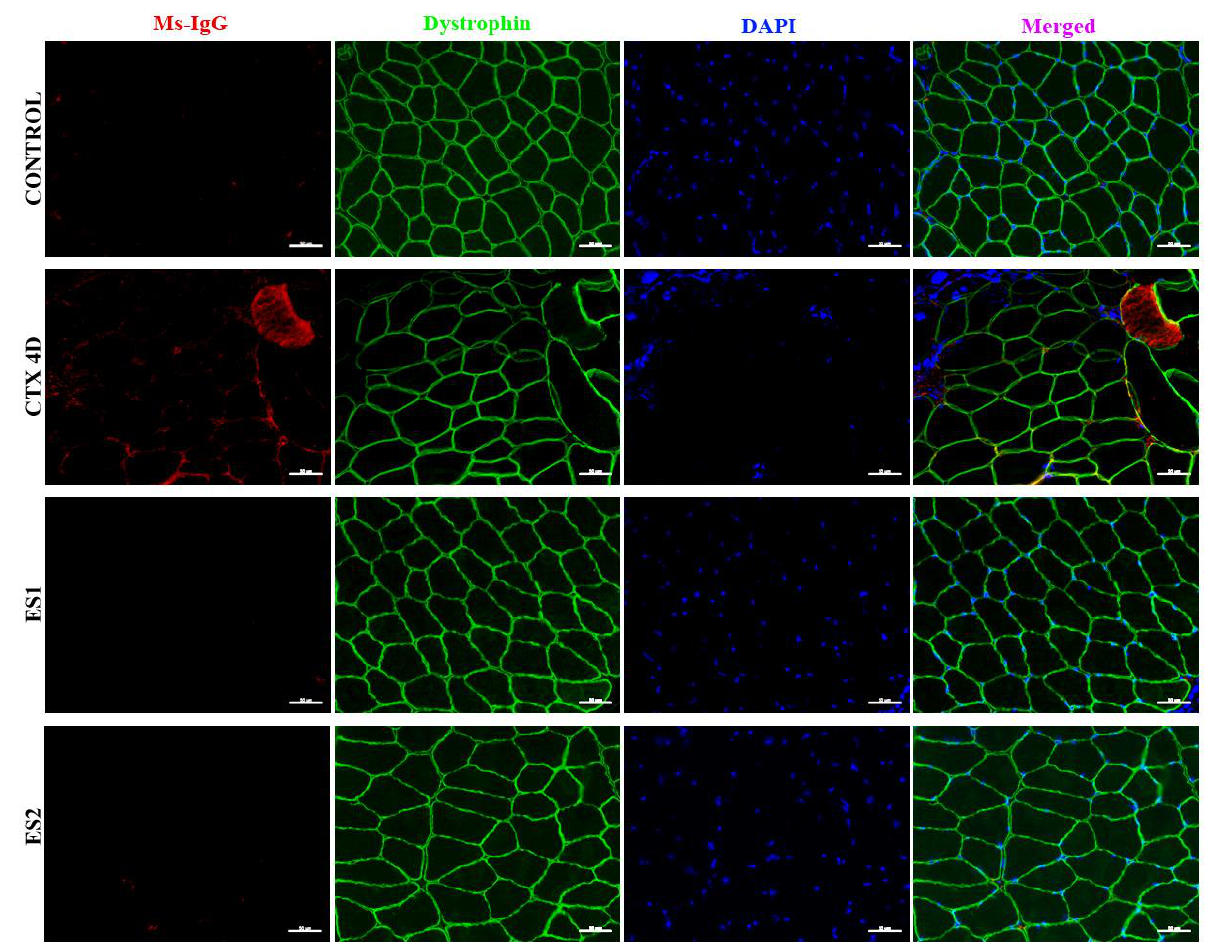
Figure 2. Representative immunofluorescence micrographs of IgG-positive (red), dystrophin (green), and DAPI (blue) after one (ES1, n = 5) and two (ES2, n = 5) weeks of electrical stimulation and 4 days after cardiotoxin injection (CTX 4D, n = 4) compared to control (CTR, n = 5). Scale bar: 50 µm.